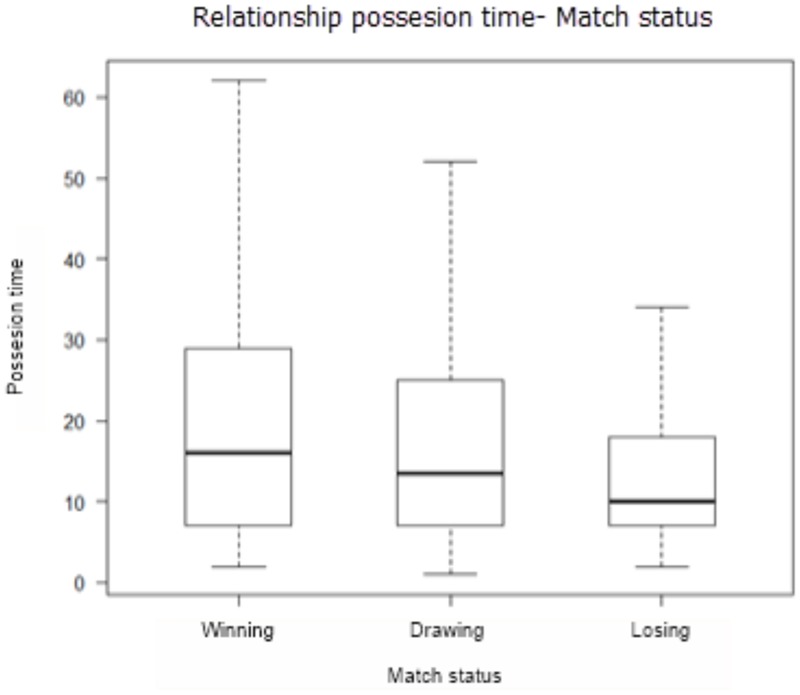
Match status and possession time diagram box.